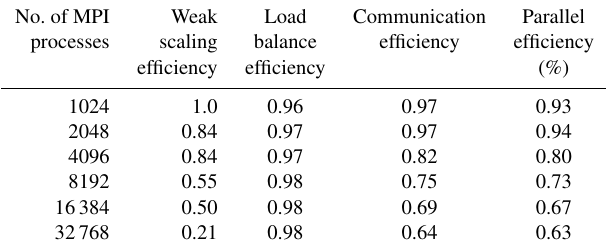
Table 1. Time taken to run the ParFlow test case on JUQUEEN (IBM Blue Gene/Q) with 16 MPI processes using three different commonly used compiler flag optimizations.